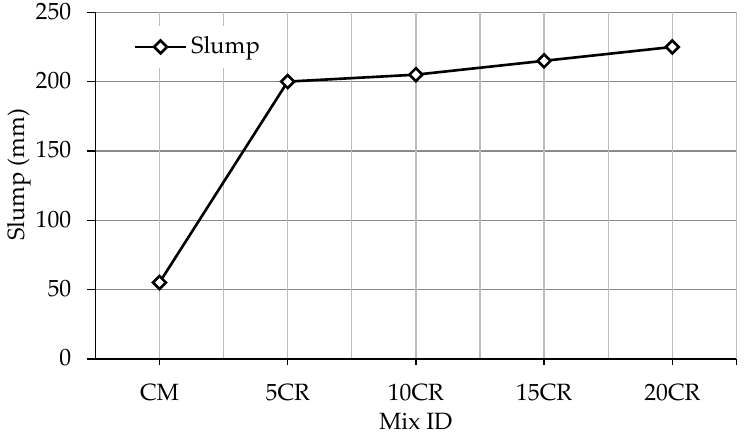
Figure 5. Slump test results.